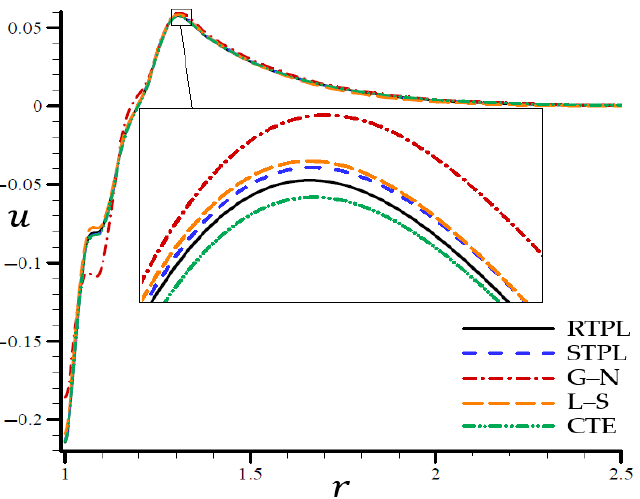
Figure 4. The radial displacement 𝑢 through the radial direction of the spherical hole for all models.